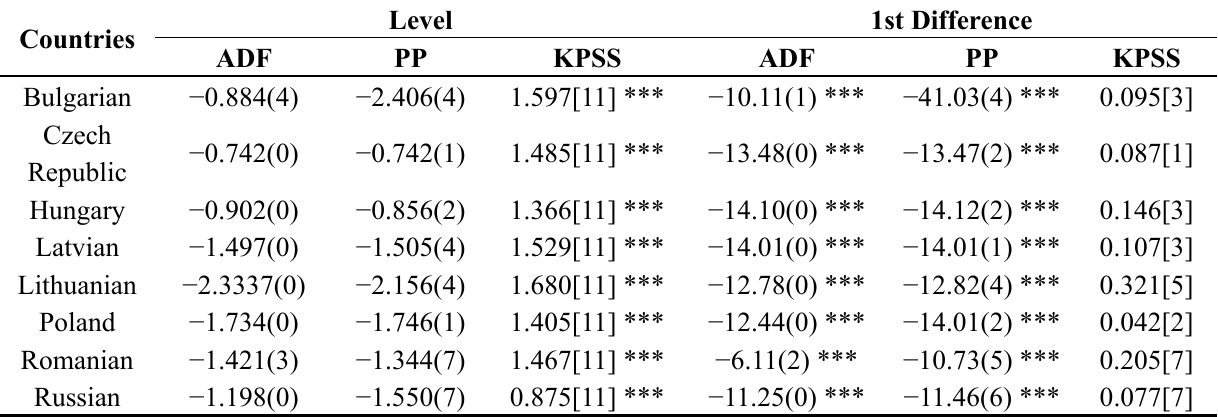
Table 1. Univariate unit root tests. ADF, augmented Dickey-Fuller; PP, Phillips and Perron.